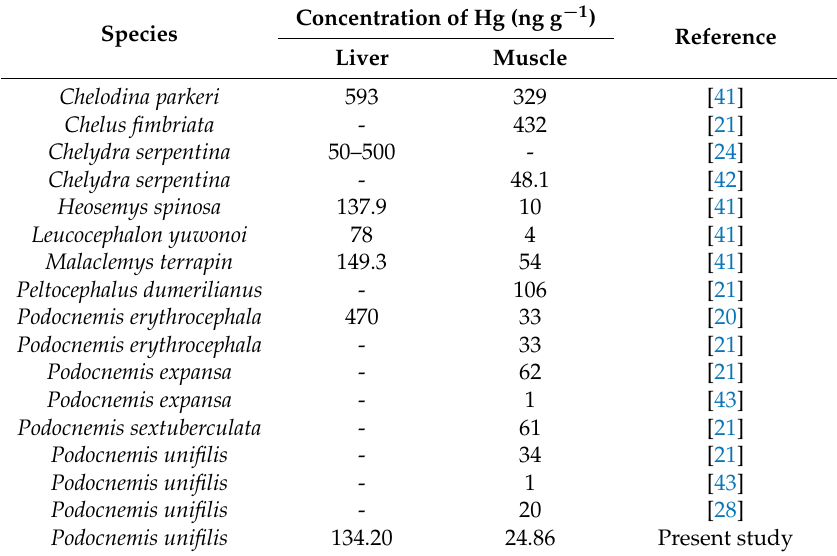
Table 3. Published data on mercury (Hg) concentration in